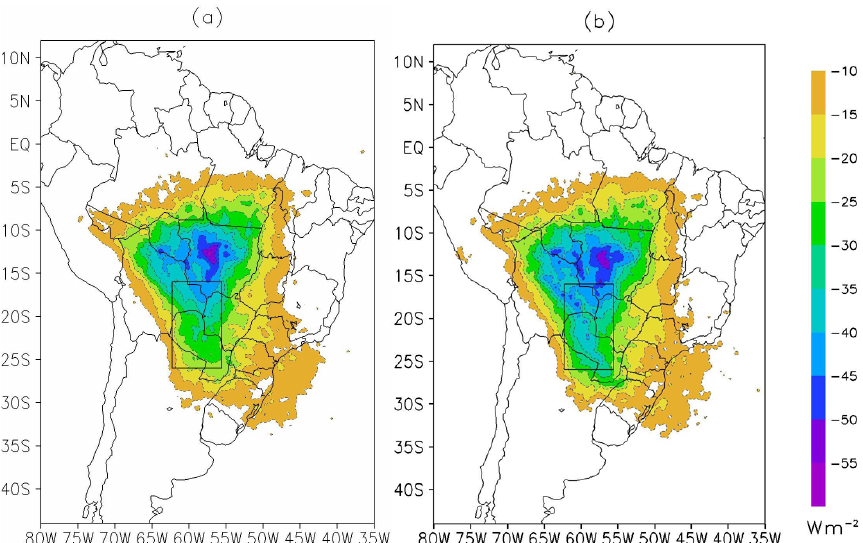
Fig. 10. Biomass burning season mean 24h surface radiative flux perturbation calculated by averaging differences between downward surface solar irradiance including and excluding the aerosol direct radiative effect. (a) Using a static aerosol optical properties model and (b) prescribing spatially varying optical properties models. The black boxes highlight the region where major differences are expected between assumptions (a) and (b) .